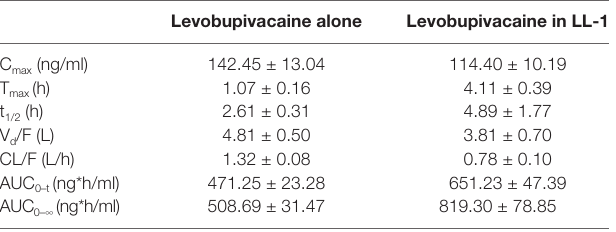
TABLE 2 | The pharmacokinetic parameters of Levobupivacaine in plasma after sciatic nerve block in rats (Mean ± SEM). Levobupivacaine alone Levobupivacaine in LL-1